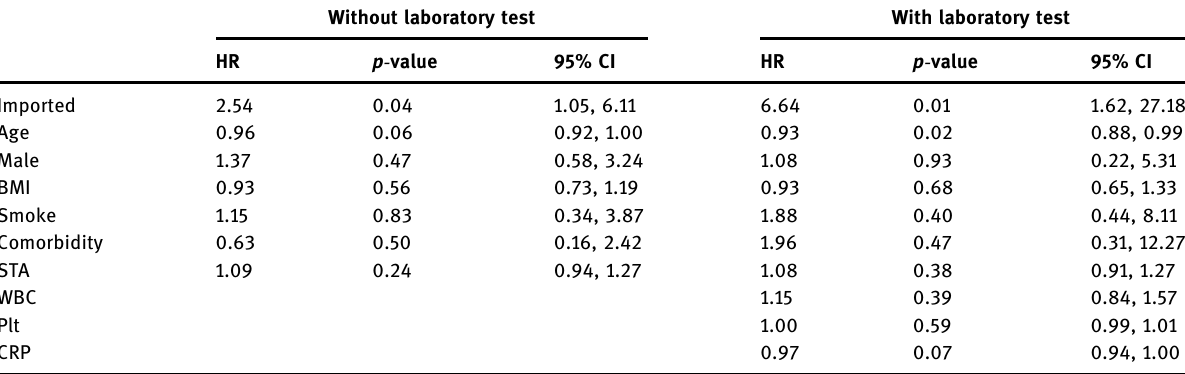
Without laboratory